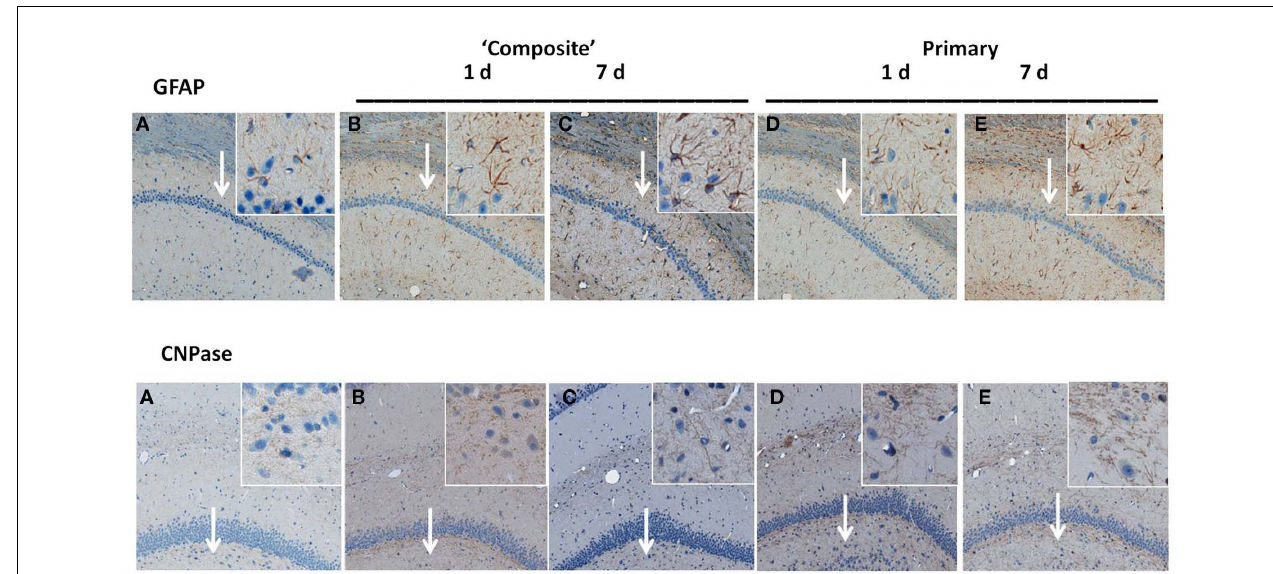
“composite” blast, 1day; (C) “composite,” 7days; (D) “primary,” 1day; and (E) “primary,” 7days. Magnifications 5 × and 20 × (insets) are shown. Arrows indicate inset locations for CA1 region (GFAP) and DG region (CNPase) in hippocampus. Please see Section “Materials and Methods” for details.